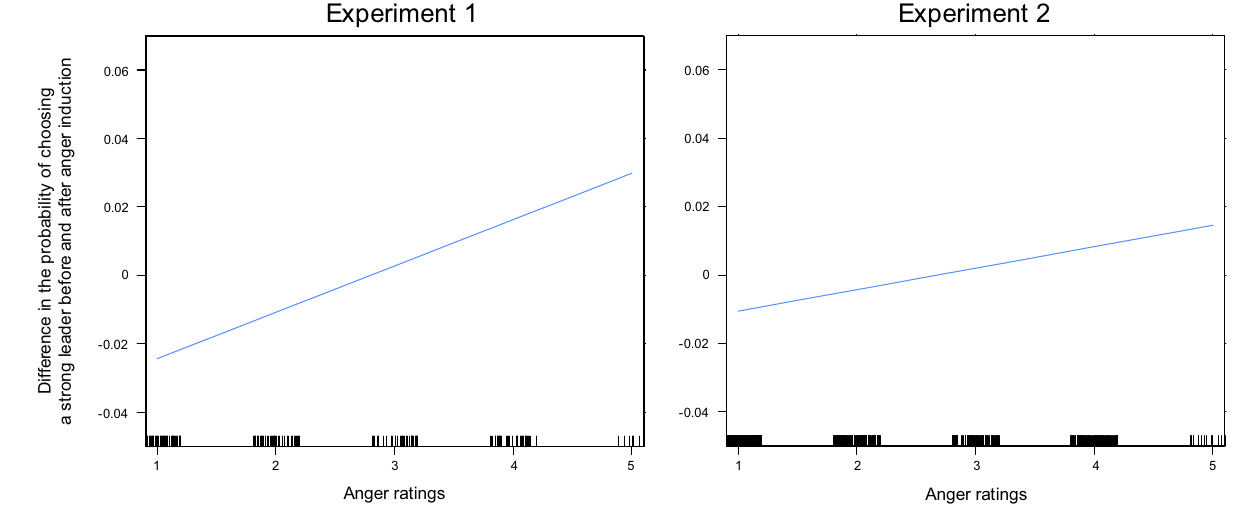
Figure 2. Association between experienced anger and change in leader preferences in Experiments 1 and 2. Left panel: The relationship between the dependant variable (ProbPost–ProbPre) and anger ratings estimated by the full regression model (with anger, anxiety, attentiveness, political affiliation and TAS as predictors) for the two experiment is plotted together with the 95% confidence intervals (Left: Experiment 1; Right: Experiment